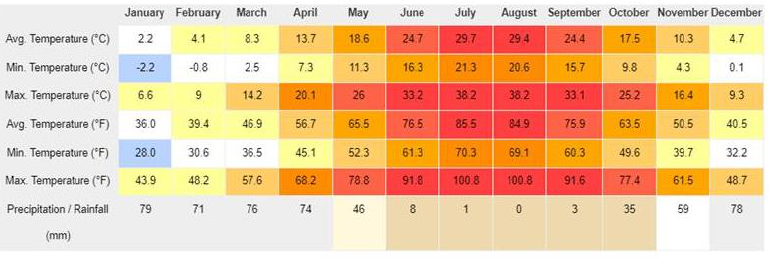
Figure 3. Satellite view of historical Old Town texture—Şilbe collective housing settlement unit [17,18].